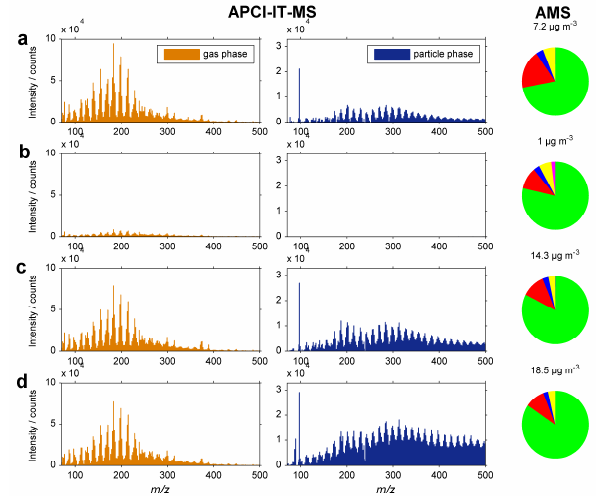
Fig. 2. Average composition of the gas and particle phase on four Figure 2. Average composition of the gas- and particle- phase on four different days during 2 different days during HUMPPA-COPEC 2010 (Fig. 1a–d) measured HUMPPA-COPEC 2010 (a-d, Fig.1) measured by APCI-IT-MS and AMS. Black carbon is 3 by APCI-IT-MS and AMS. Black carbon is not included in the AMS not included in the AMS pie charts but in the numbered submicron mass concentration. 4 pie charts but in the numbered submicron mass